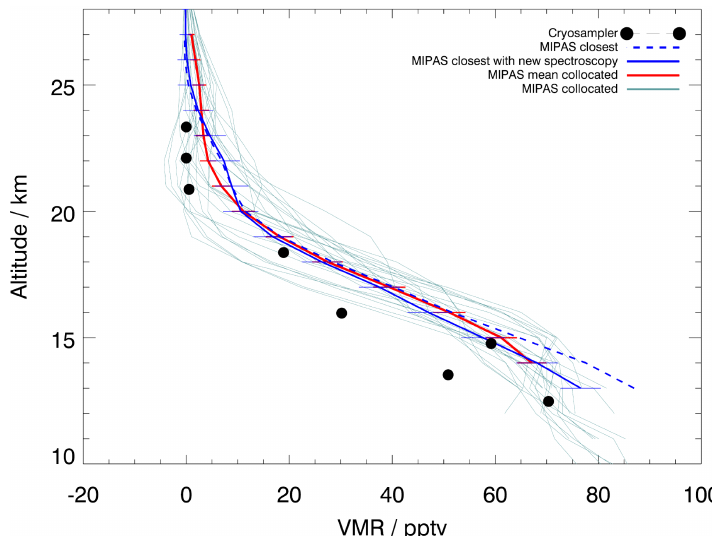
Figure 16. Comparison of MIPAS Envisat and cryosampler CCl 4 . The cryosampler measurement was taken on 1 April 2011. The continuous and dashed blue lines are the respective closest MIPAS Envisat profiles calculated using the new and the old spectroscopic data